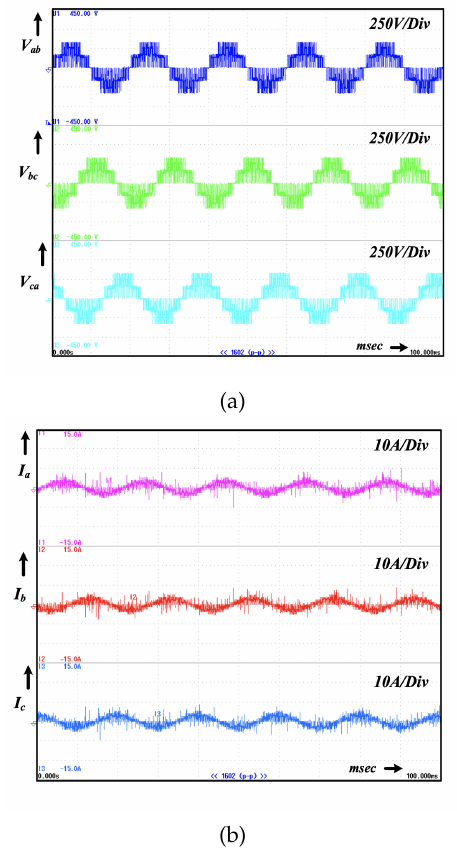
Fig. 9. Experimental results for M a = 0.9: (a) line voltage V ab , V bc , V ca , [250V/div] [1ms/div], (b) Phase current voltage I a , I b , I c , [10A/div] [1ms/div]